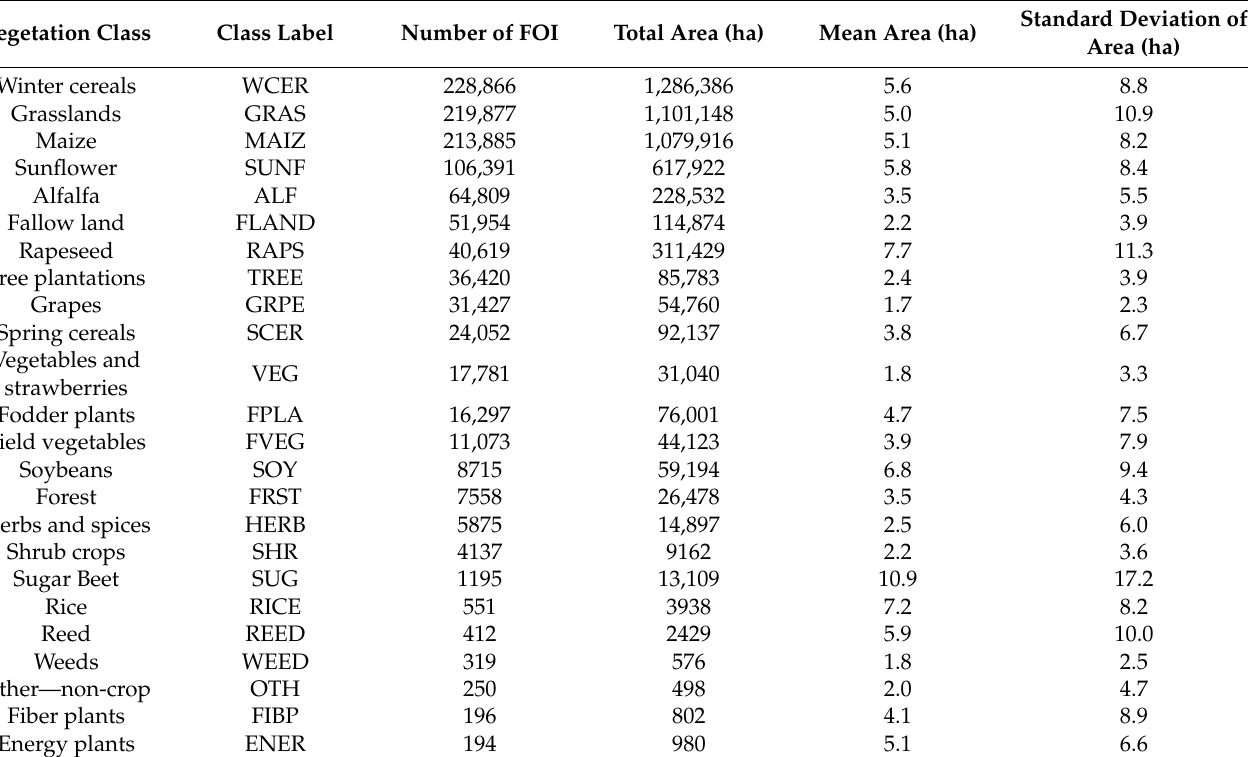
Table 1. Overview information for the vegetation classes used in this